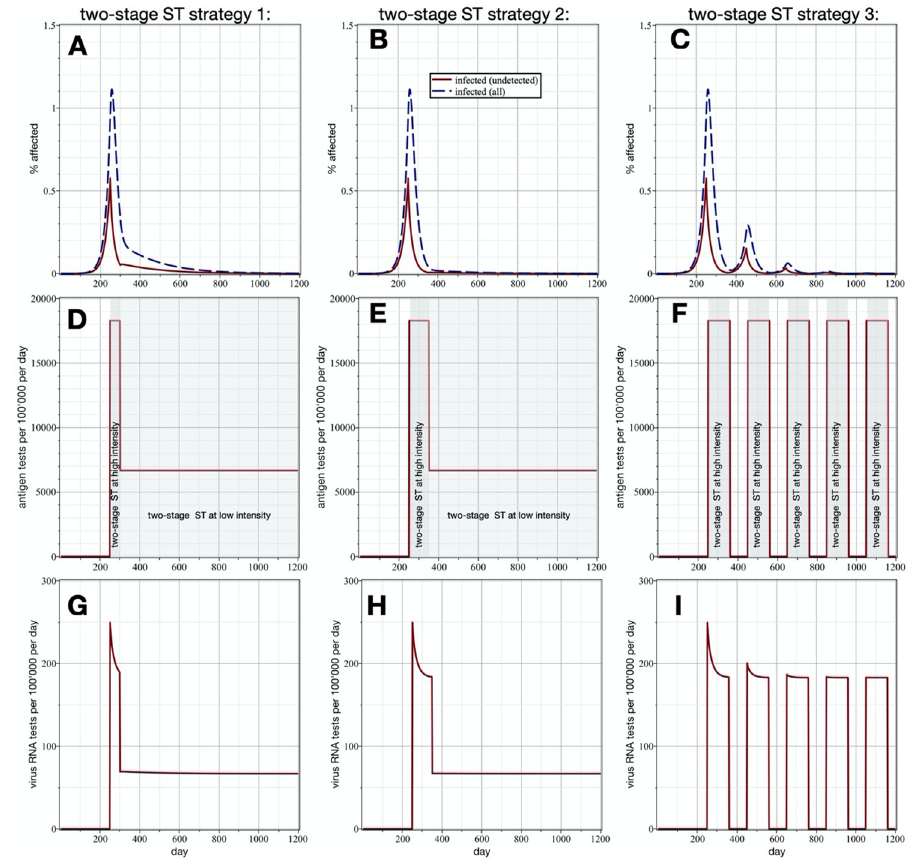
Fig 4. Different two-stage ST mitigation strategies. Shown are overall prevalence and prevalence in the undetected population (A-C; dashed and solid lines, respectively), and number of virus antigen and RNA tests per 100’000 people per day (D-F and G-I, respectively). The unmitigated reproduction number is 1.6 (already reduced by moderate social distancing) and each scenario starts on day 250, when the prevalence just exceeded 1%. The first scenario (first column) follows a two-stage ST strategy, in which for a first period of 50 days 18% of population is virus antigen tested every day. Once the prevalence is reduced by almost one order of magnitude, two-stage ST is continued at a lower intensity, that is, with 7% of the population being antigen tested every day. The second scenario (second column) is identical to the first one, except that the first phase lasts for 100 days, which leads to a reduction of the prevalence by almost two orders of magnitude. In the third scenario (third column), two-stage ST (with 18% of the population being antigen tested every day) is applied in cycles; each cycle starts with 110 days of two-stage ST followed by a 90 day pause. A 95% sensitivity and one day delay is assumed for the virus RNA tests, and for the antigen tests sensitivity and specificity of 70% and 99% are assumed.